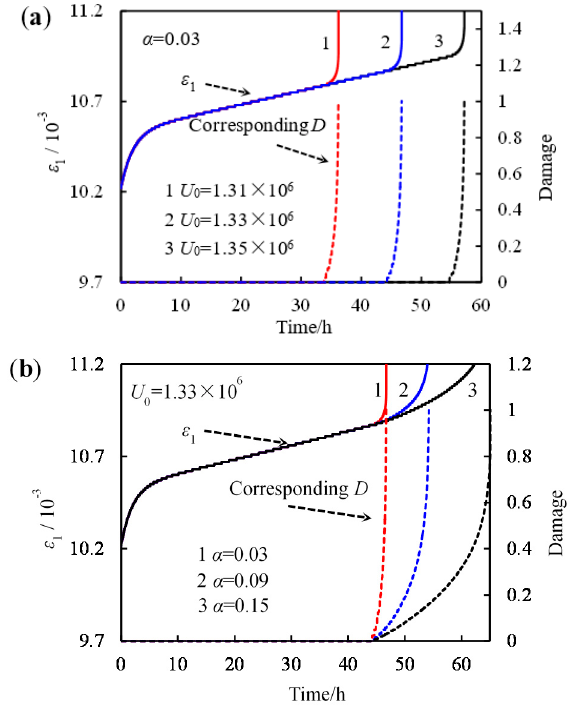
= 1.33 × 10 6 (Note: K = 0